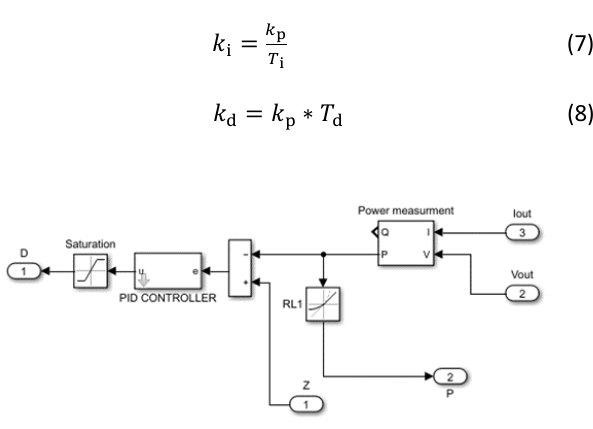
Fig.5: PID-ZNS controller for the proposed ESU.